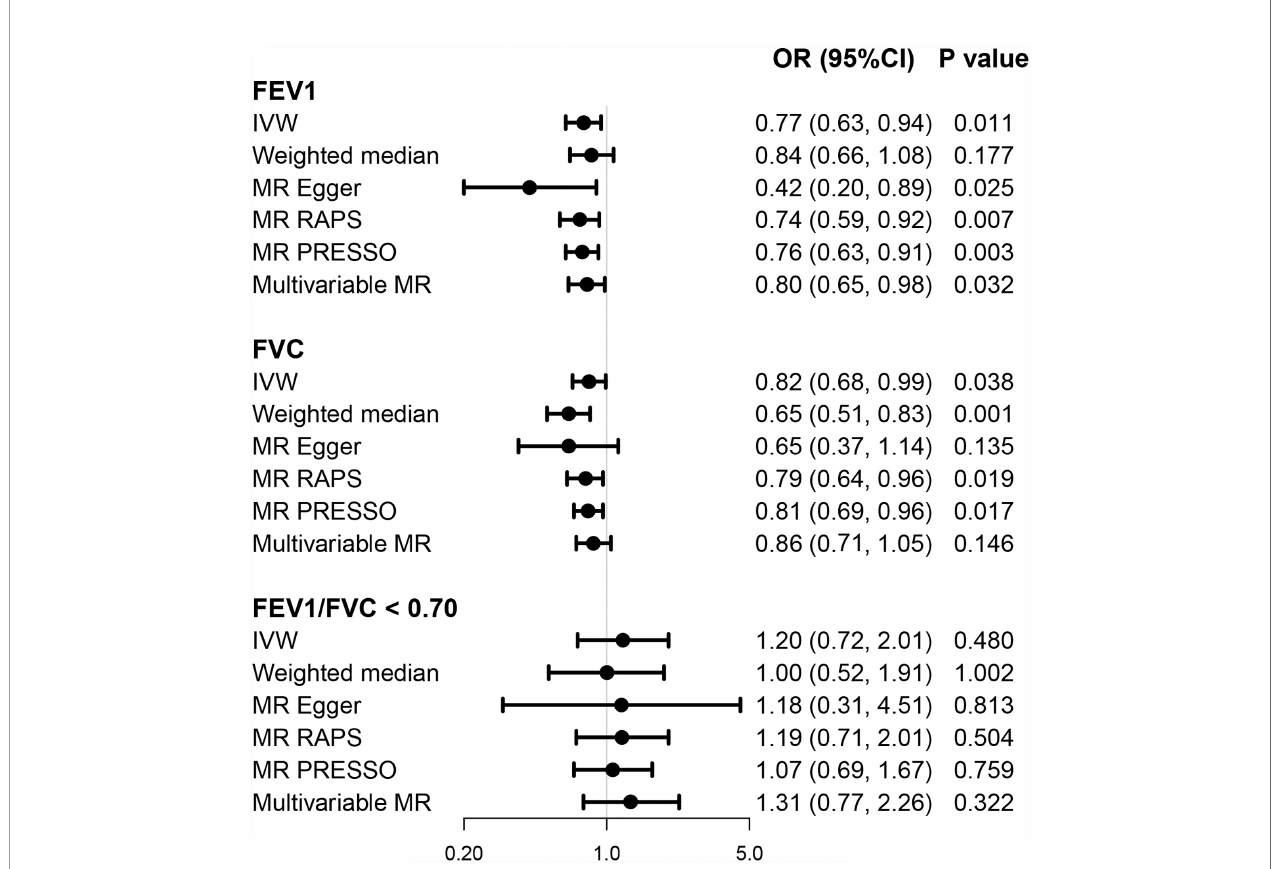
FIGURE 4 | Causal effects of pulmonary function on T2D. OR (95% CI) represents per one-SD increase in FEV1 and FVC and per one-unit increase in log e odds of FEV1/FVC < 0.70. FEV1, forced expiratory volume in 1 s; FVC, forced vital capacity; OR, odds ratio; T2D, type 2